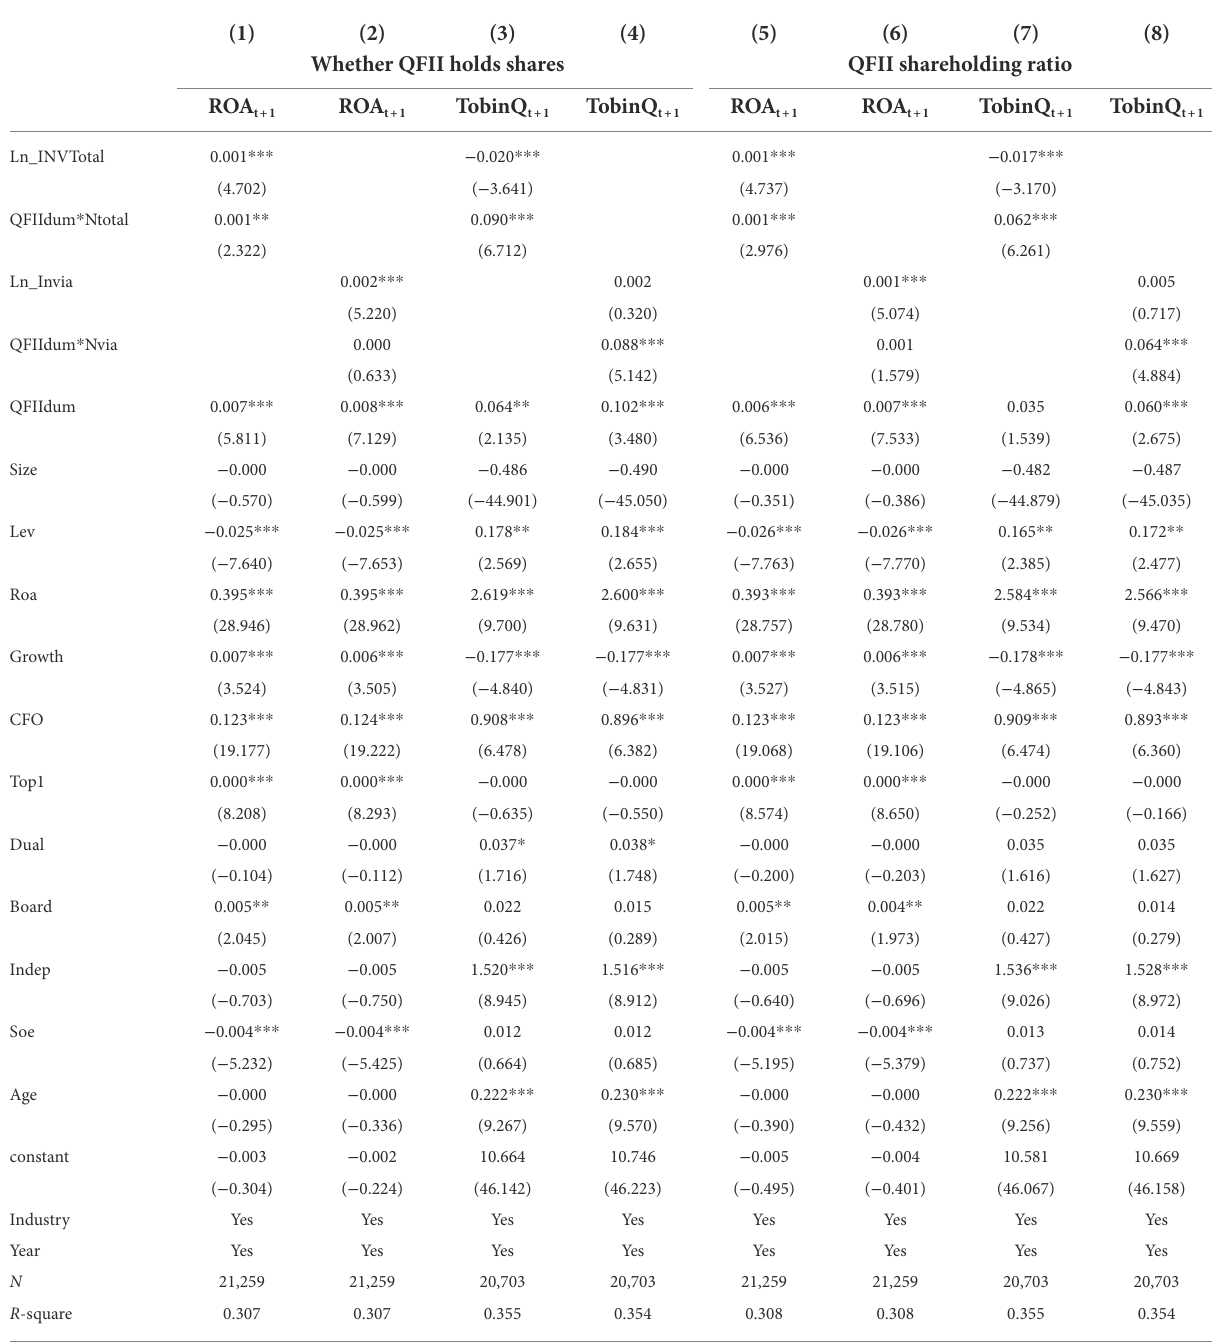
TABLE 11 QFII, corporate innovation, corporate performance, and